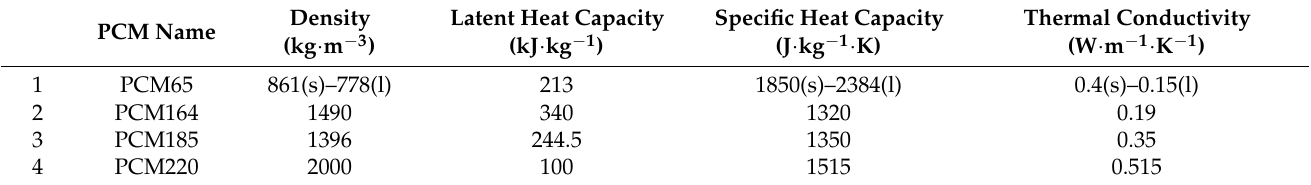
Table 2. Properties of the PCMs [33,41].